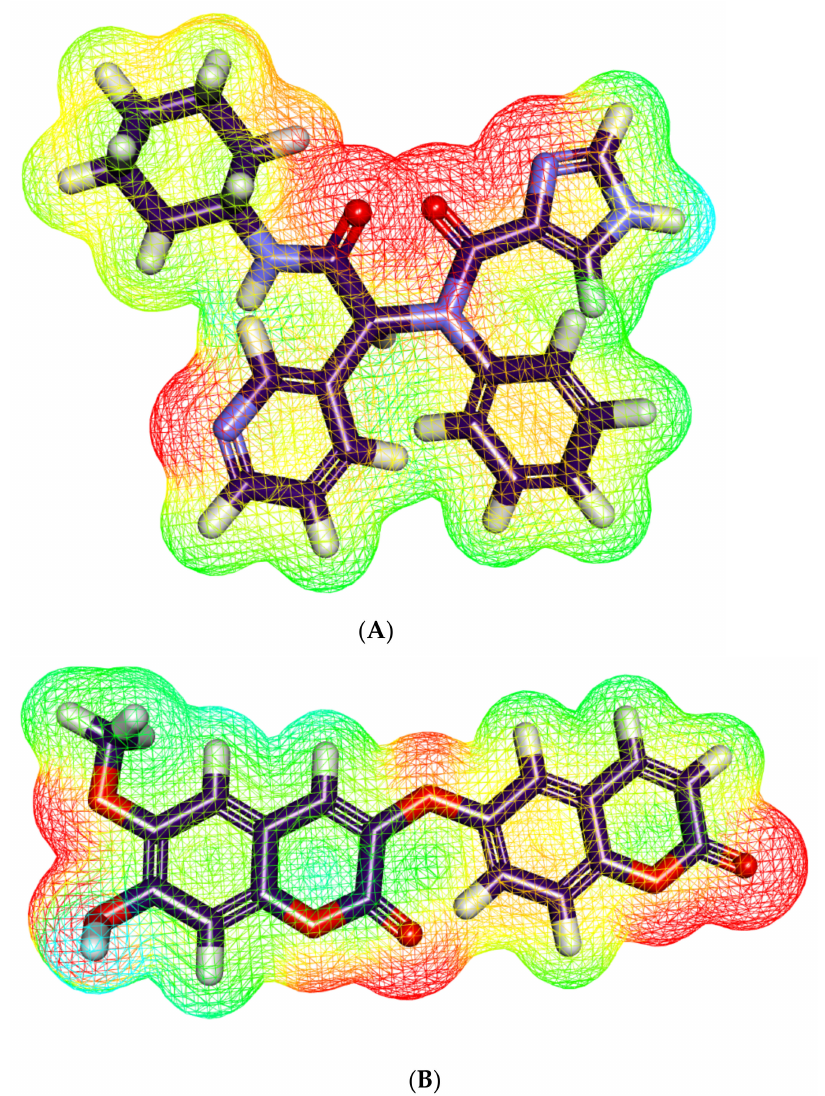
Figure 8. Molecular electrostatic potential map of ( A ) X77 and ( B ) jusan coumarin. The red zones refer to the electronegative atoms that can participate as hydrogen acceptors; the blue zones refer to the electron-poor atoms that can participate as hydrogen bonds donors; and the yellow and green zones refer to the neutral atoms that can form hydrophobic interactions. X77 has four red zones, one blue zone, and four yellow zones. Jusan coumarin has eight red zones, two blue zones, and three yellow